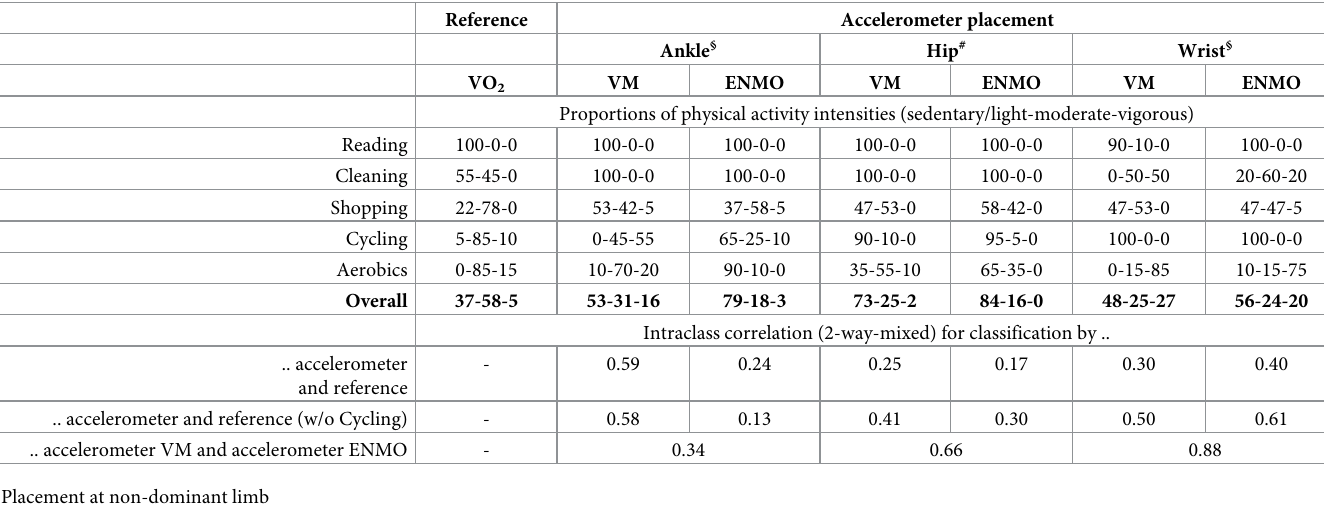
Table 4. Robustness of derived cut-points tested in all staged free-living activities all